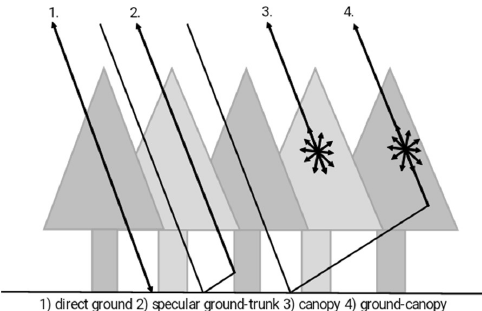
Figure 1. Scattering mechanisms of forests.